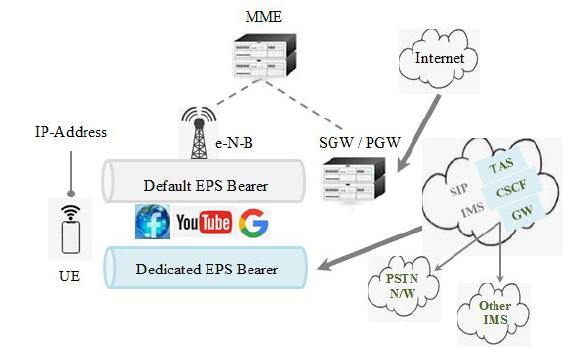
Fig. 5. An organizational management proposal as an example is dedicated to Internet